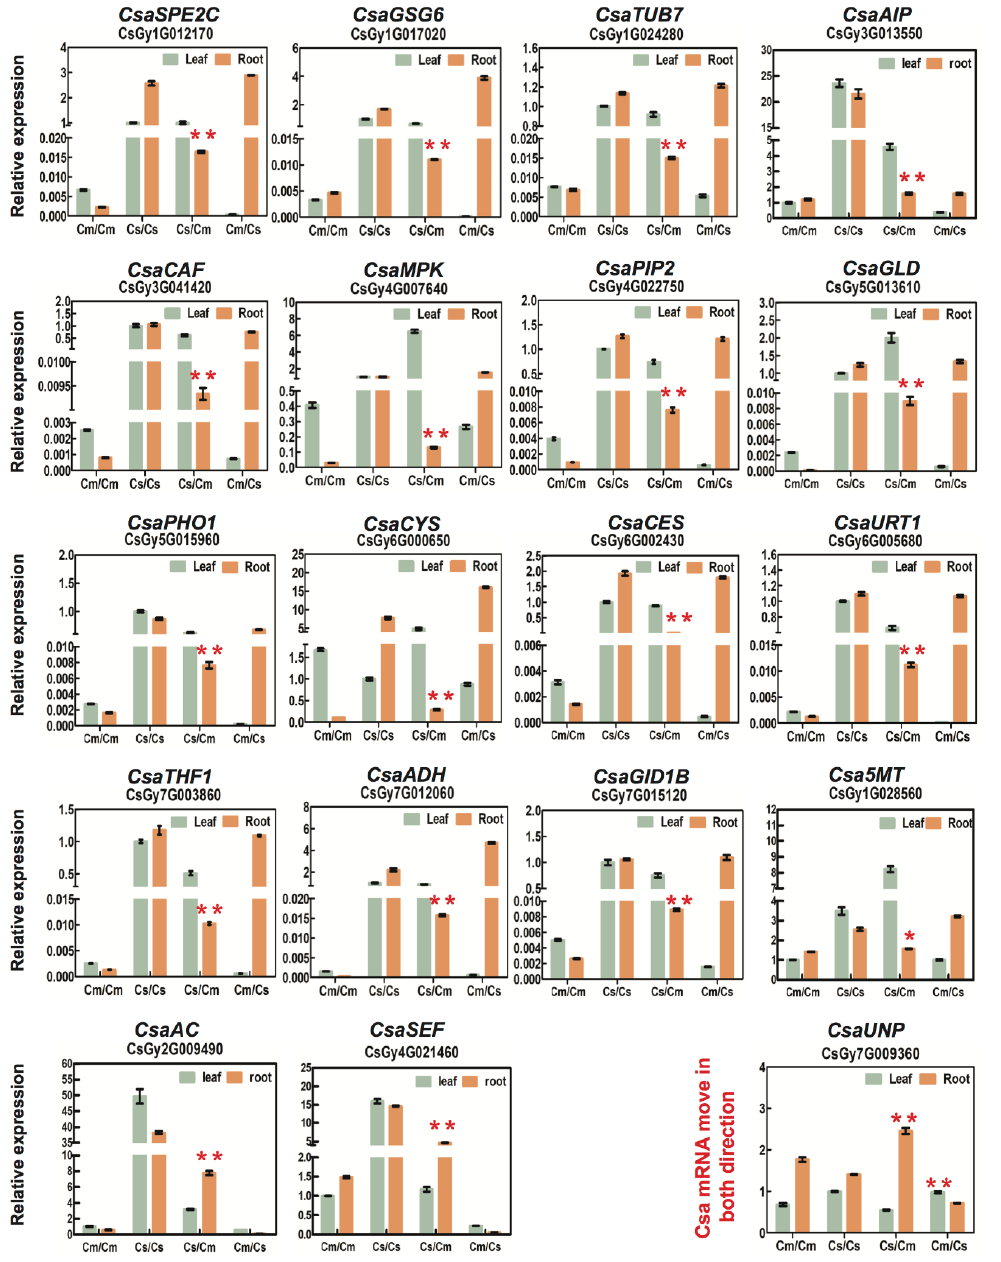
Figure 9. RT-qPCR verification of selected Cmo mRNA mobility and movement direction in heterografts. Specific primers recognizing Cmo transcripts were used for RT-qPCR, which identified an extremely low mRNA abundance in control Csa / Csa homografts. A significant increase in mRNA abundance either in Csa / Cmo shoot or Cmo / Csa root suggested potential downward, upward, or bidirectional movement of Cmo mRNA. Graphs were generated by GraphPad Prism5.0. Red asterisks indicate highly significant di ff erences from the same tissue of homograft controls using t -test for independence of variables in a contingency table. Biological replicates: n > 9. Error bars indicate standard deviation. Cs, Cucumis sativus ; Cm, Cucurbita moschata